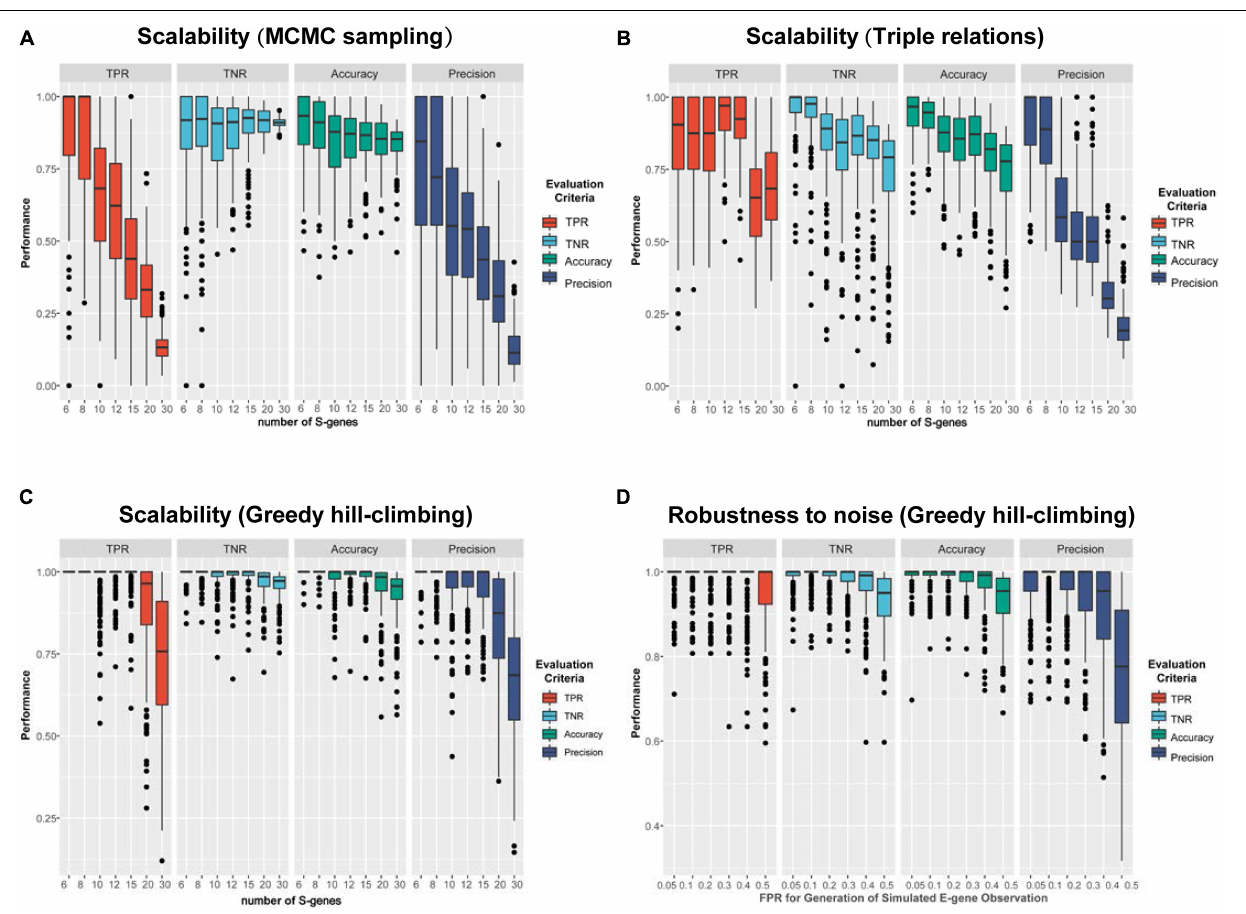
FIGURE 4 | A comparison of the performance of three representative network inference strategies. (A–C) The performance of NEM-Tar based on (A) MCMC sampling, (B) triple relations, and (C) greedy hill-climbing, respectively, on simulated data for varying numbers of S-genes. For each method, we generated 200 random signaling networks and inferred their structures using NEM-Tar from the simulated E-gene data. (D) The performance of NEM-Tar based on greedy hill-climbing testing its robustness to simulated data with different levels of